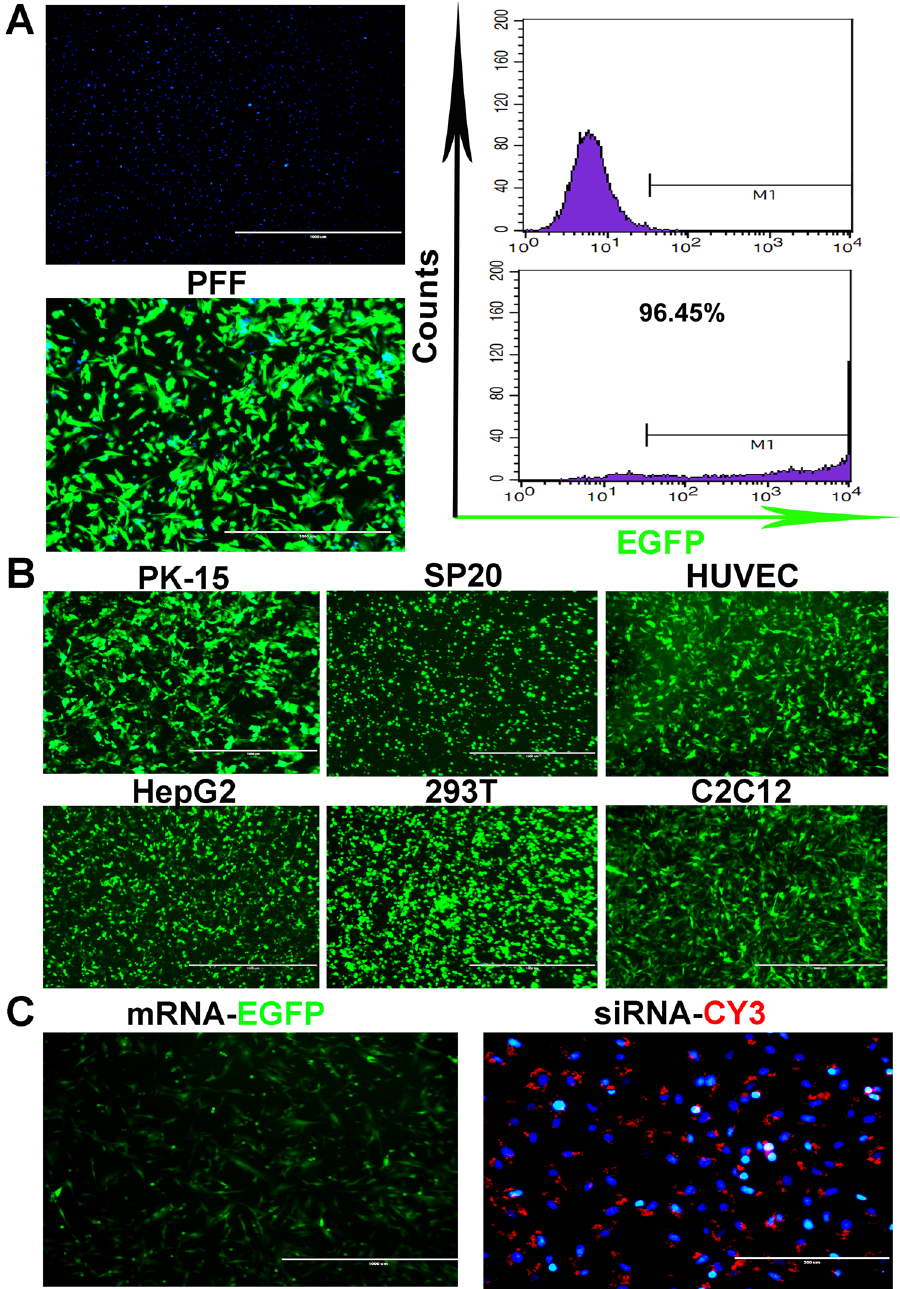
Figure 1. An efficient and versatile electroporation system. ( A ) Transient transfection of the pEGFP-N1 vectors into the PFFs. The transfection efficiency was analysed with fluorescence microscopy and FACS at 24 hours post-transfection. ( B ) Transient transfection of the pEGFP-N1 vector into the indicated cell lines. EGFP fluorescence was analysed via fluorescence microscopy. ( C ) Transfection of the EGFP mRNA and CY3-labelled siRNA into PFFs. The fluorescence was analysed via fluorescence